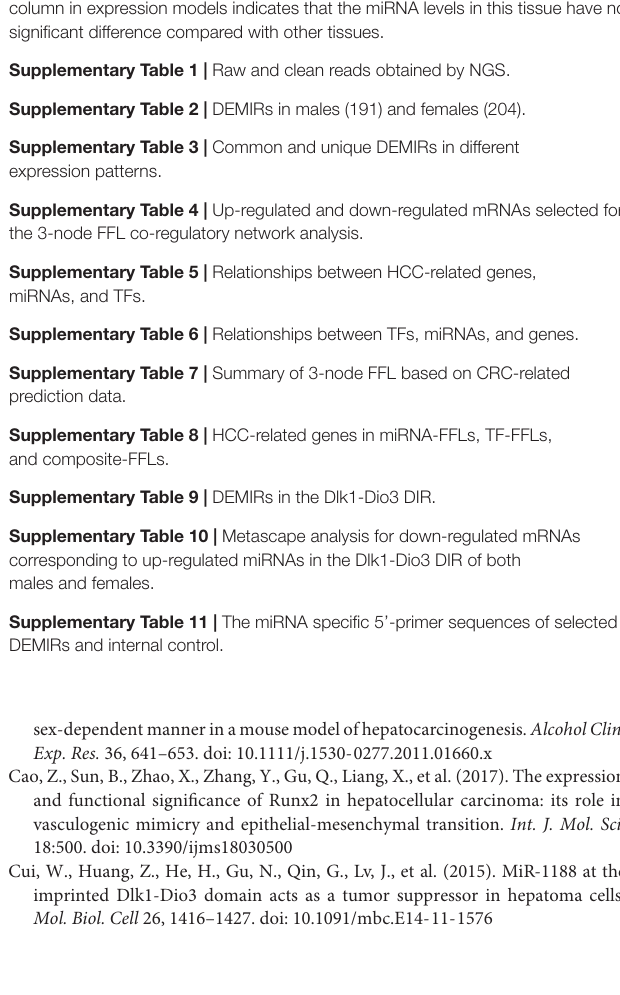
Supplementary Table 2 | DEMIRs in males (191) and females (204). Supplementary Table 3 | Common and unique DEMIRs in different expression patterns.